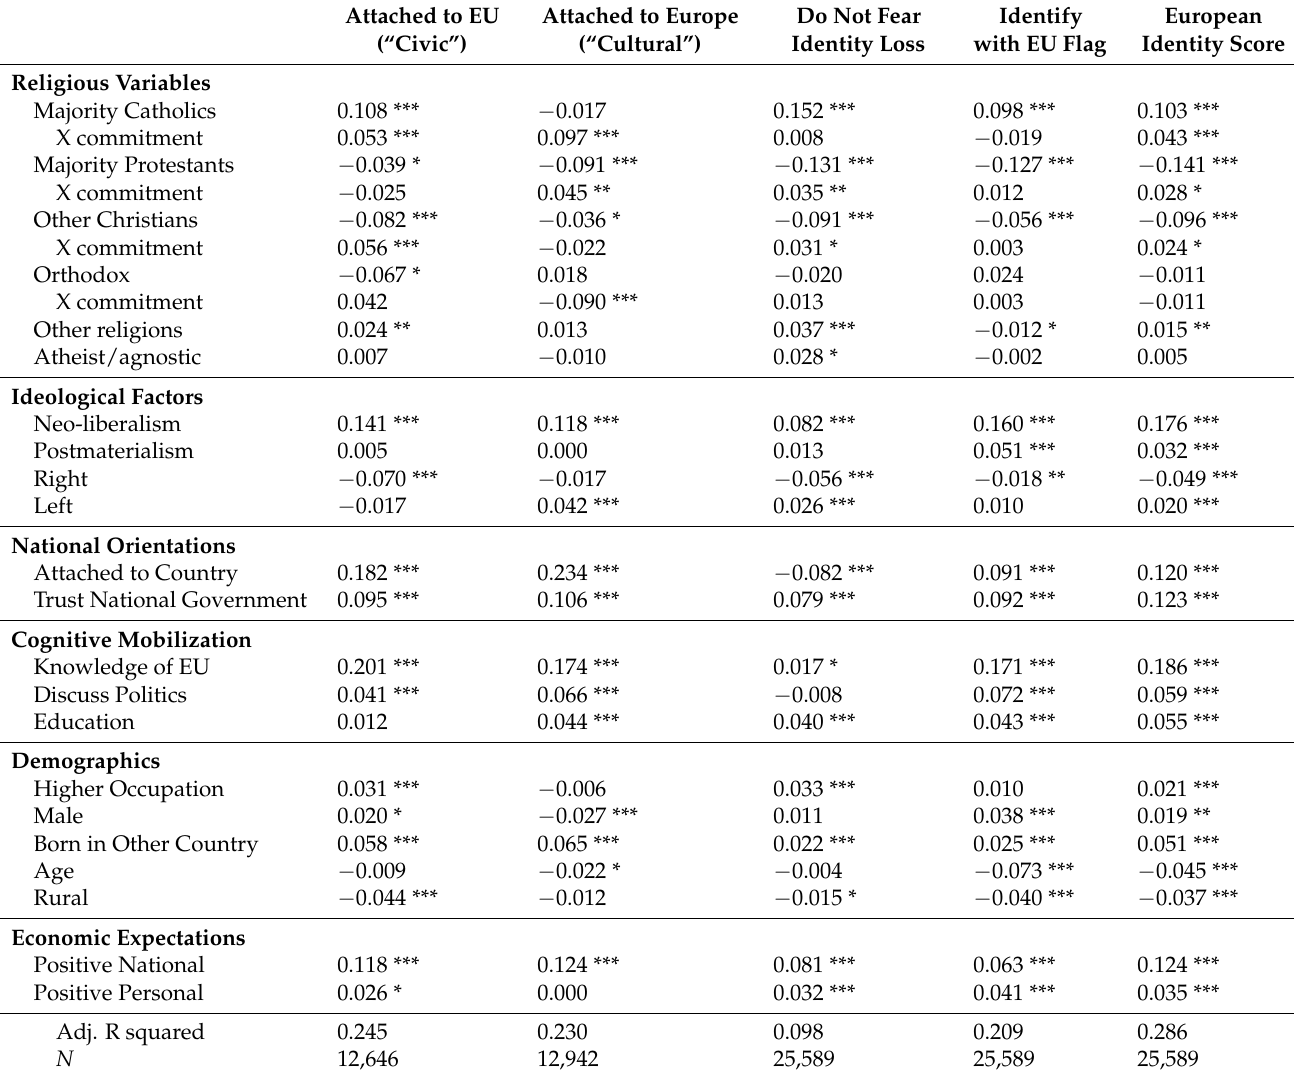
Table 2. European Identity and Individual Traits (OLS regression betas